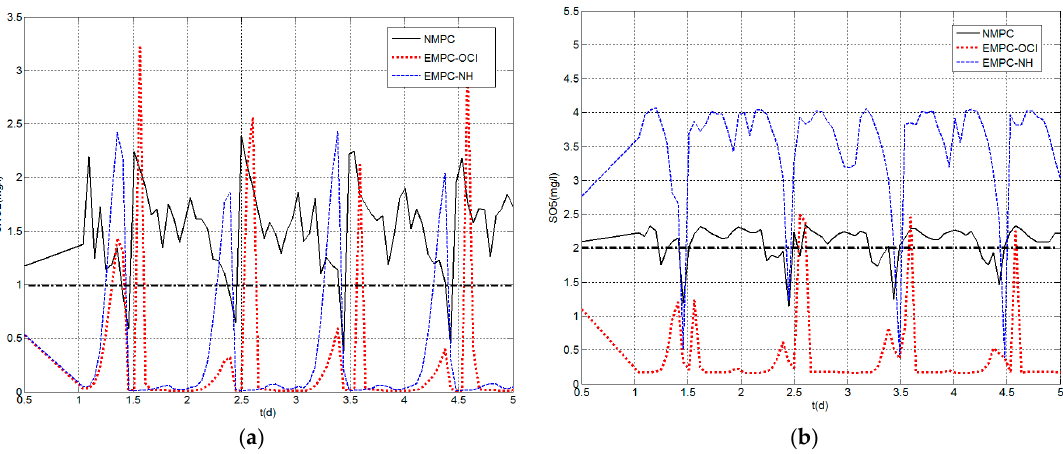
Figure 6. BSM1-controlled variables’ responses under NMPC and EMPC controllers. ( a ) Nitrates and nitrites concentration in the second rector ( S NO2 ) response ( b ) dissolved oxygen in the last aerobic reactor ( S O5 ) response. EMPC: economic-oriented model predictive controller.